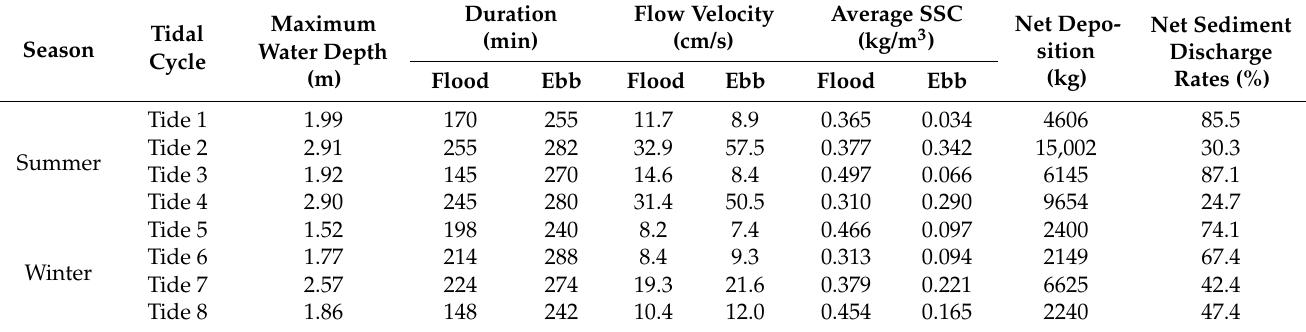
Table 1. Duration, time–depth-averaged flow velocity, and average SSC during flood and ebb